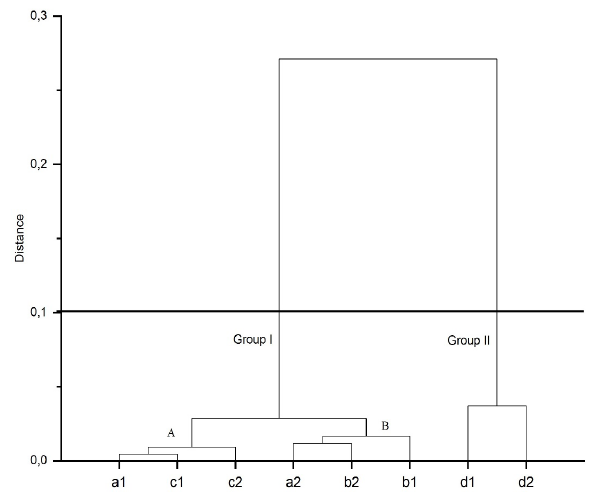
Figure 8: Hierarchical Cluster Analysis (HCA) for the FTIR spectra of all oil